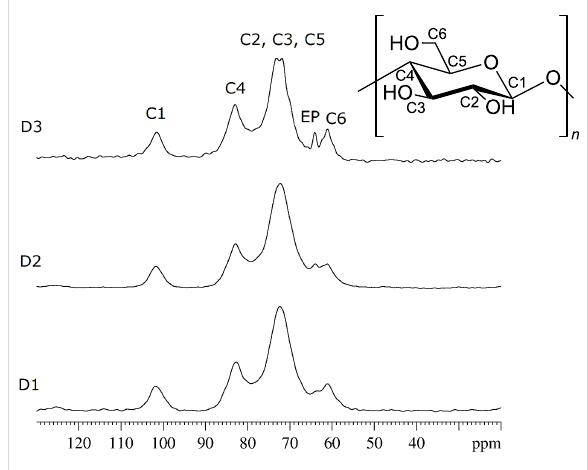
Figure 3: 13 C { 1 H} CP-MAS spectra of polymers D1, D2 and D3. Peak assignment is given in the upper trace.